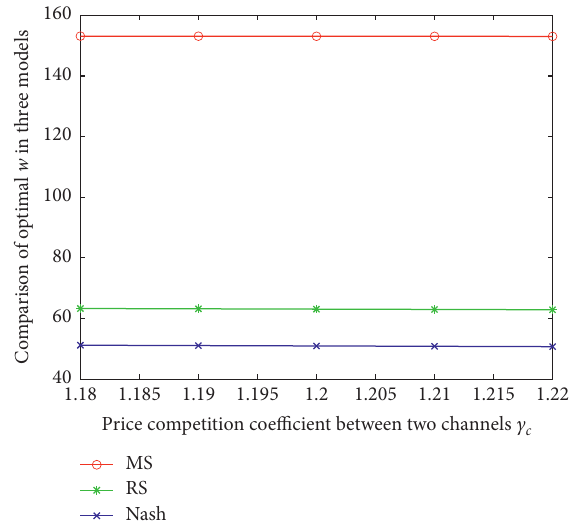
Figure 7: The comparison of the optimal direct sales price of standard products p m in the three models.